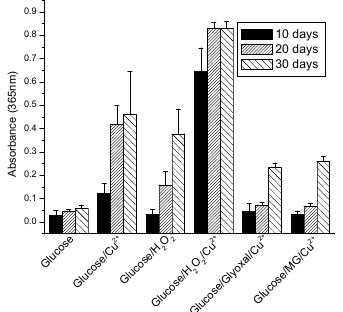
Figure 3. Effect of mixtures: glucose (5 mM)/Cu 2+ (5 μ M), glucose (5mM)/H 2 O 2 (0.5 mM) , glucose (5 mM)/Cu 2+ (5 μ M)/H 2 O 2 (0.5 mM), glucose (5 mM)/Cu 2+ (5 μ M)/glyoxal (0.5 mM) and glucose (5 mM)/Cu 2+ (5 μ M)/methylglyoxal (5 mM) in the generation of the major chromophore arising from glucose degradation. Incubations were performed during 10, 20 and 30 days at pH 7.4 and 37 °C. Error bars indicate the standard deviation of the mean.